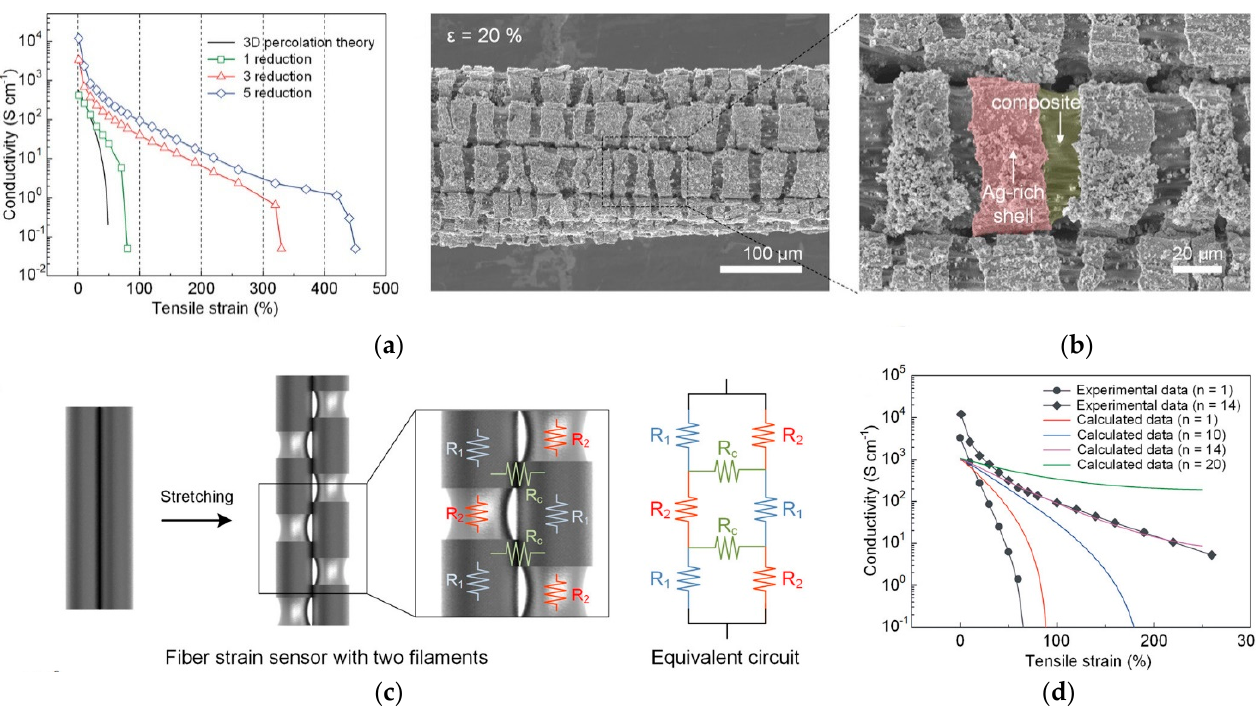
Figure 4. ( a ) The electrical conductivity of the sensor under different strains; ( b ) SEM images of the fiber strain sensor at ε = 20%; ( c ) the resistance model of the double-filament strain sensor and the corresponding equivalent circuit; ( d ) the relationship between the electrical conductivity of the single-filament/multifilament fiber strain sensor and the tensile strain; n is the number of multiple filaments in the fiber strain sensor [45].